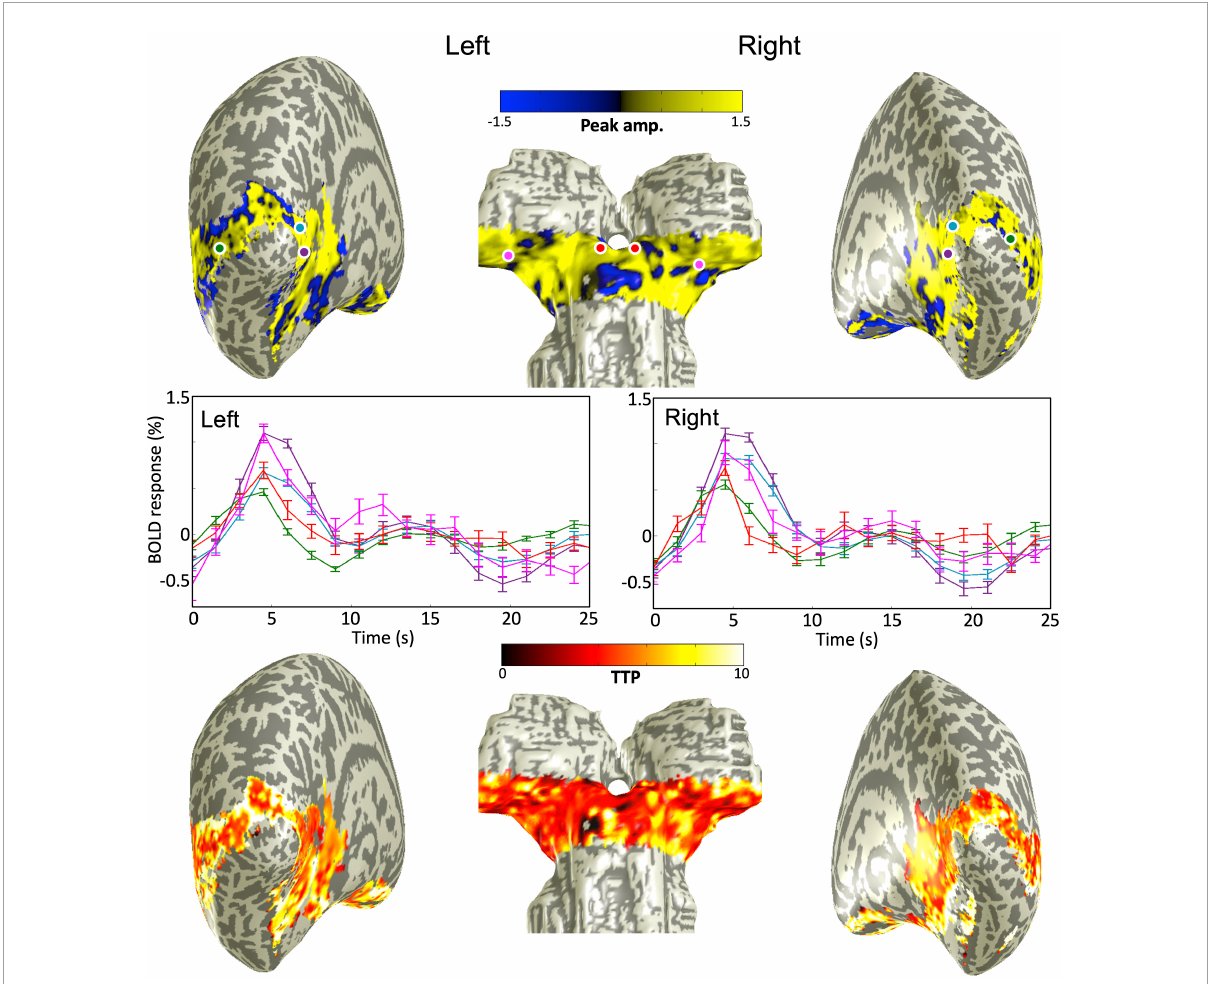
FIGURE2 (Upper) peak amplitude map overlaid on smoothed gray/white matter interface mesh for one example subject at 3T. (Middle) Sample raw HRFs corresponding to color-coded dots on the mesh above; error bars show 68% confidence intervals. (Bottom) Time-to-peak map overlaid on the smoothed mesh. All maps thresholded at a CNR >